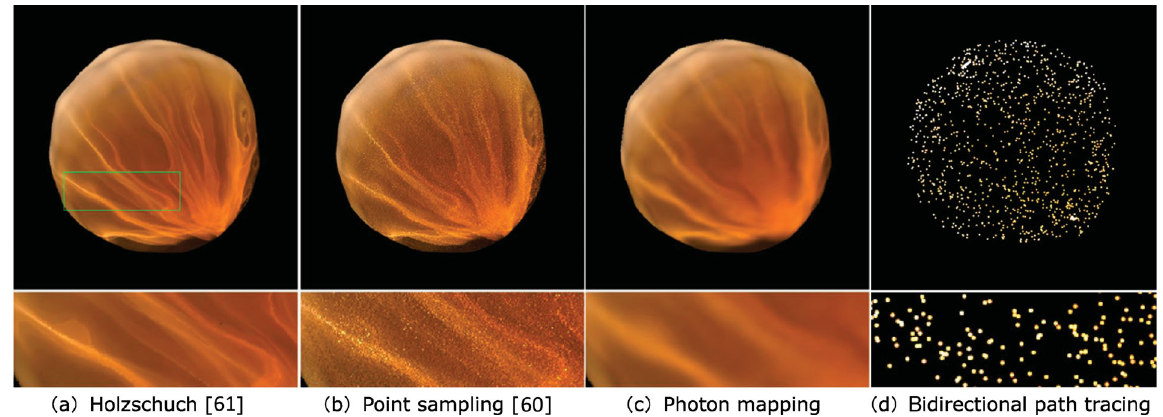
Fig. 15 Comparison among Holzschuch [61], Walter et al. [60], photon mapping, and path tracing. Reproduced with permission from Ref. [61], c (cid:2) The Author(s)